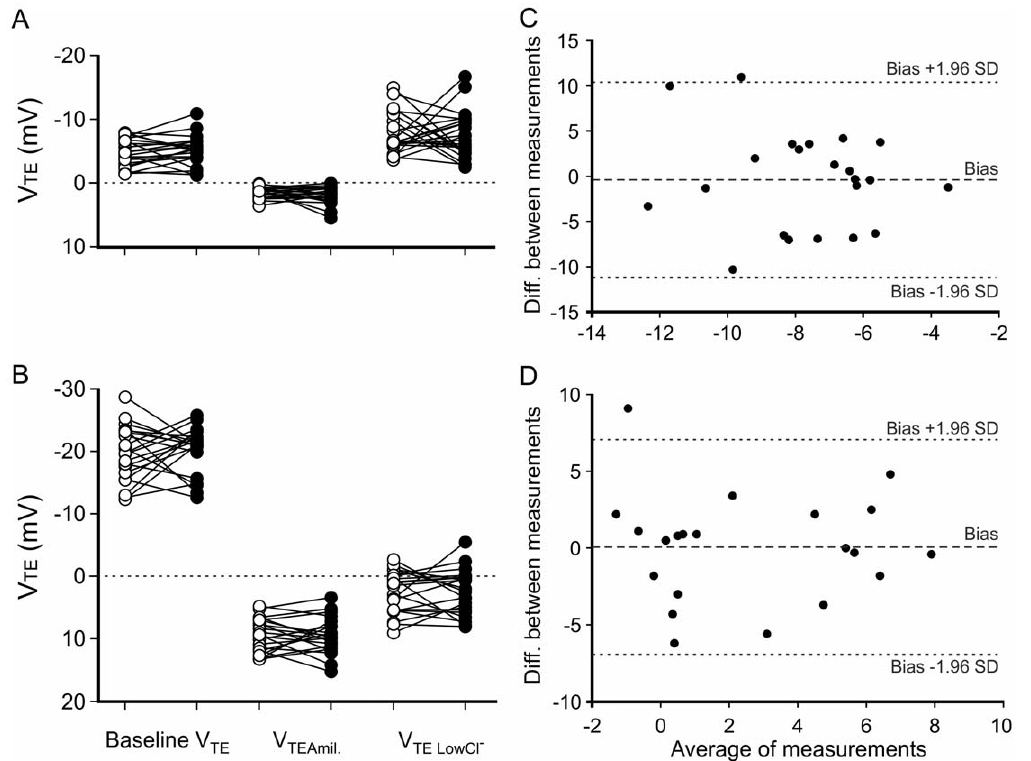
N Figure 2. Reproducibility between two measurements in B6;129 mice. The first measurement ( # ) was obtained at least 7 days before the ) on 22 WT (A) and 21 cftr -/- mice (B). The difference between the two D V TELowCl- values was plotted against their mean, as second measurement ( described by Bland and Altman, for the 22 WT (C) and 21 cftr -/- (D) mice.